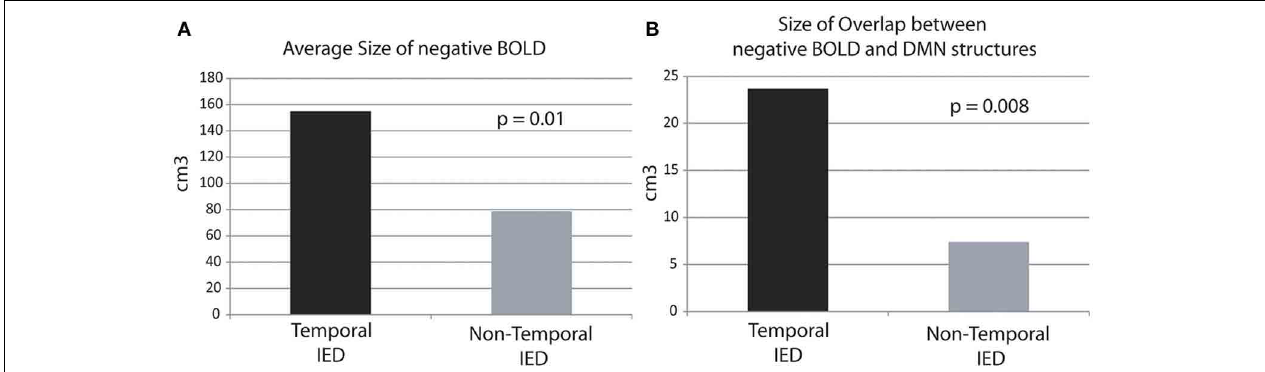
FIGURE 1 | Average size of overlap in cubic-centimeters between the negative BOLD and DMN structures in temporal and extra-temporal IED. The average size of negative BOLD as well as the overlap is significantly